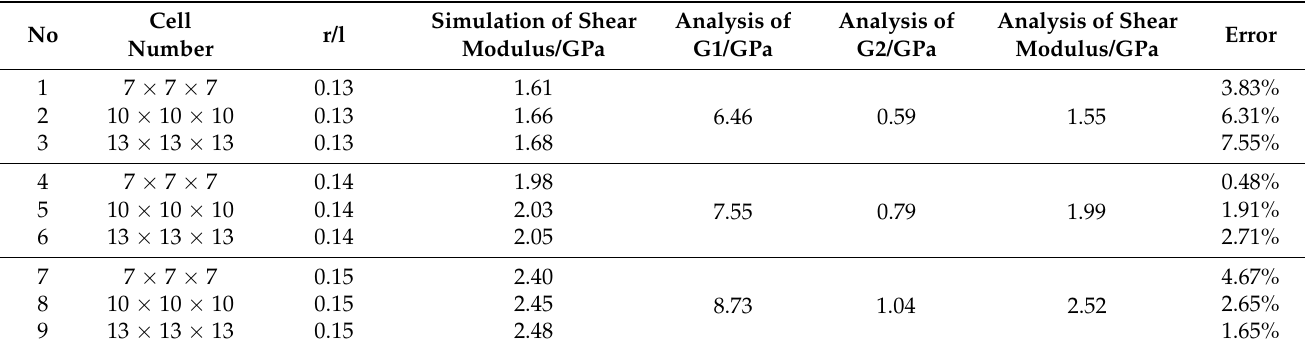
Table 3. Finite Element and Theoretical Derivation